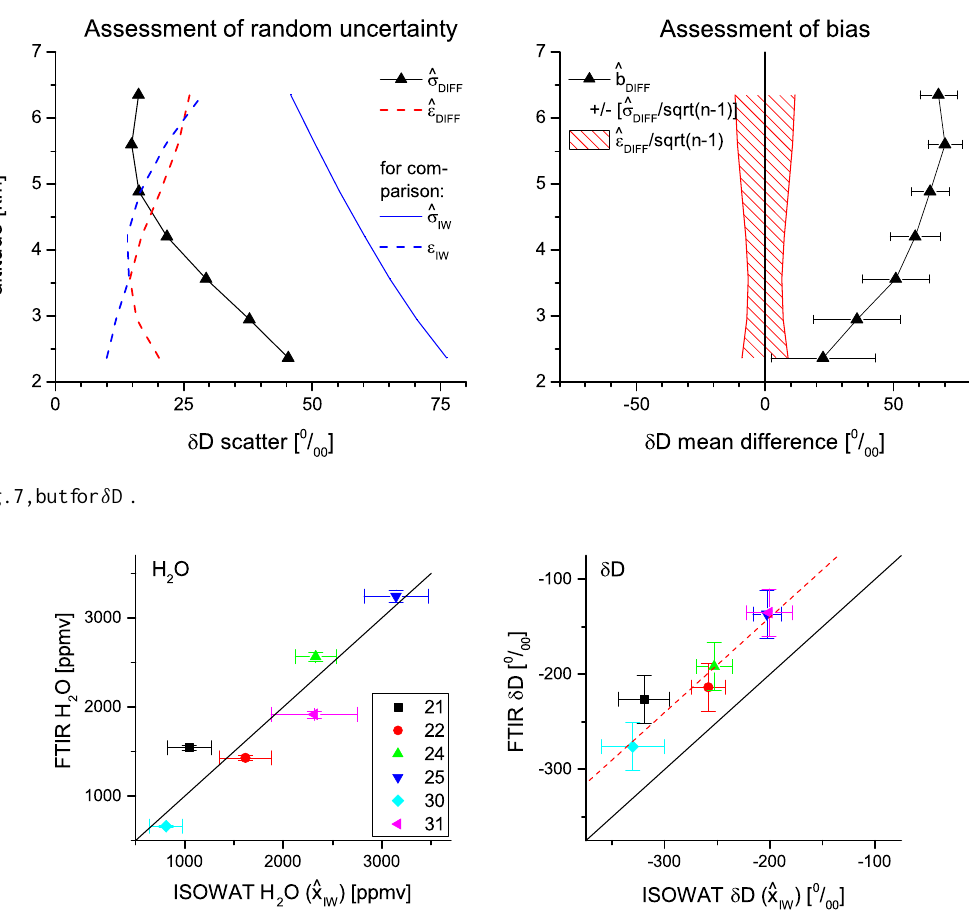
Figure 10. Correlation between ISOWAT data (smoothed with FTIR kernels) and FTIR data for 5km altitude (left for H 2 O and right for δ D). Black line is the 1:1 diagonal and red dotted line is the 1:1 diagonal shifted by + 60‰. Error bars represent the ISOWAT and FTIR uncertainty estimations. Note that a large part of the uncertainty in the smoothed ISOWAT data is due to the fact that there are no ISOWAT measurements above the aircraft’s ceiling